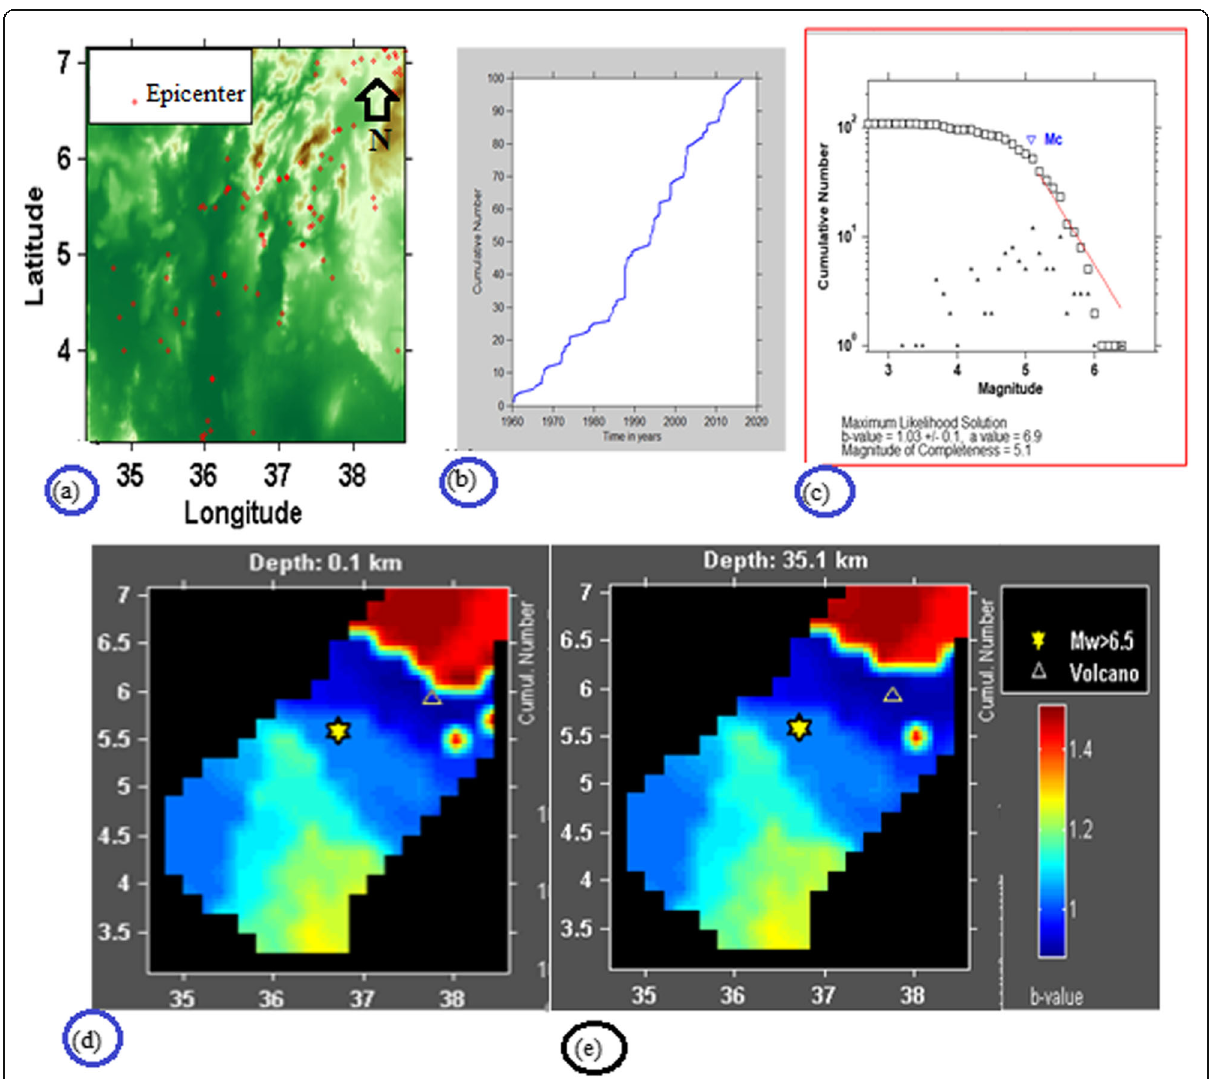
Fig. 14 Southern Main Ethiopian Rift (SMER): ( a ) Seismicity map of SMER ( b ) Cumulative number of events vs time-straight-line trend -relatively complete ( c ) average values of seismicity parameters (a, b values and Mc) using maximum likelihood method; depth slices of b-value of the SMER at depth of ( d ) 1 km ( e ) 35